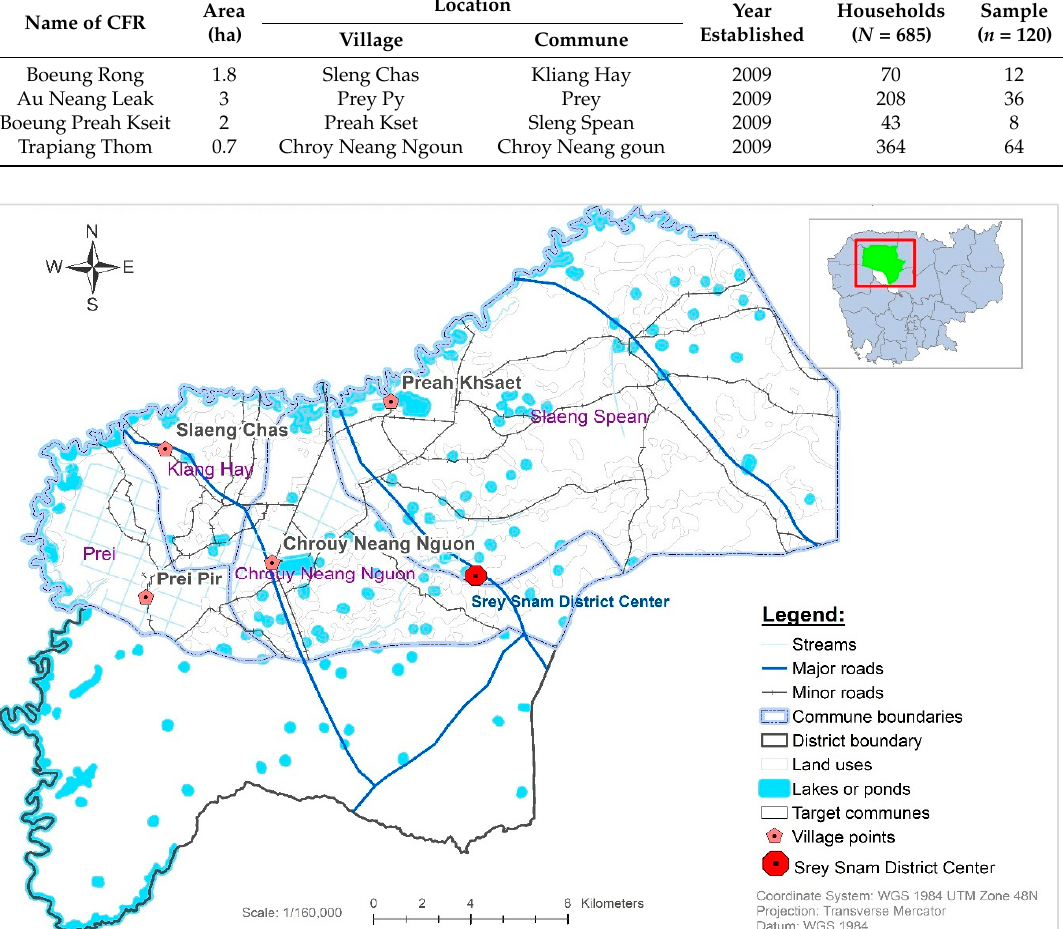
Table 1. Study sites in Srey Snam district and information about community fish refuge (CFR).